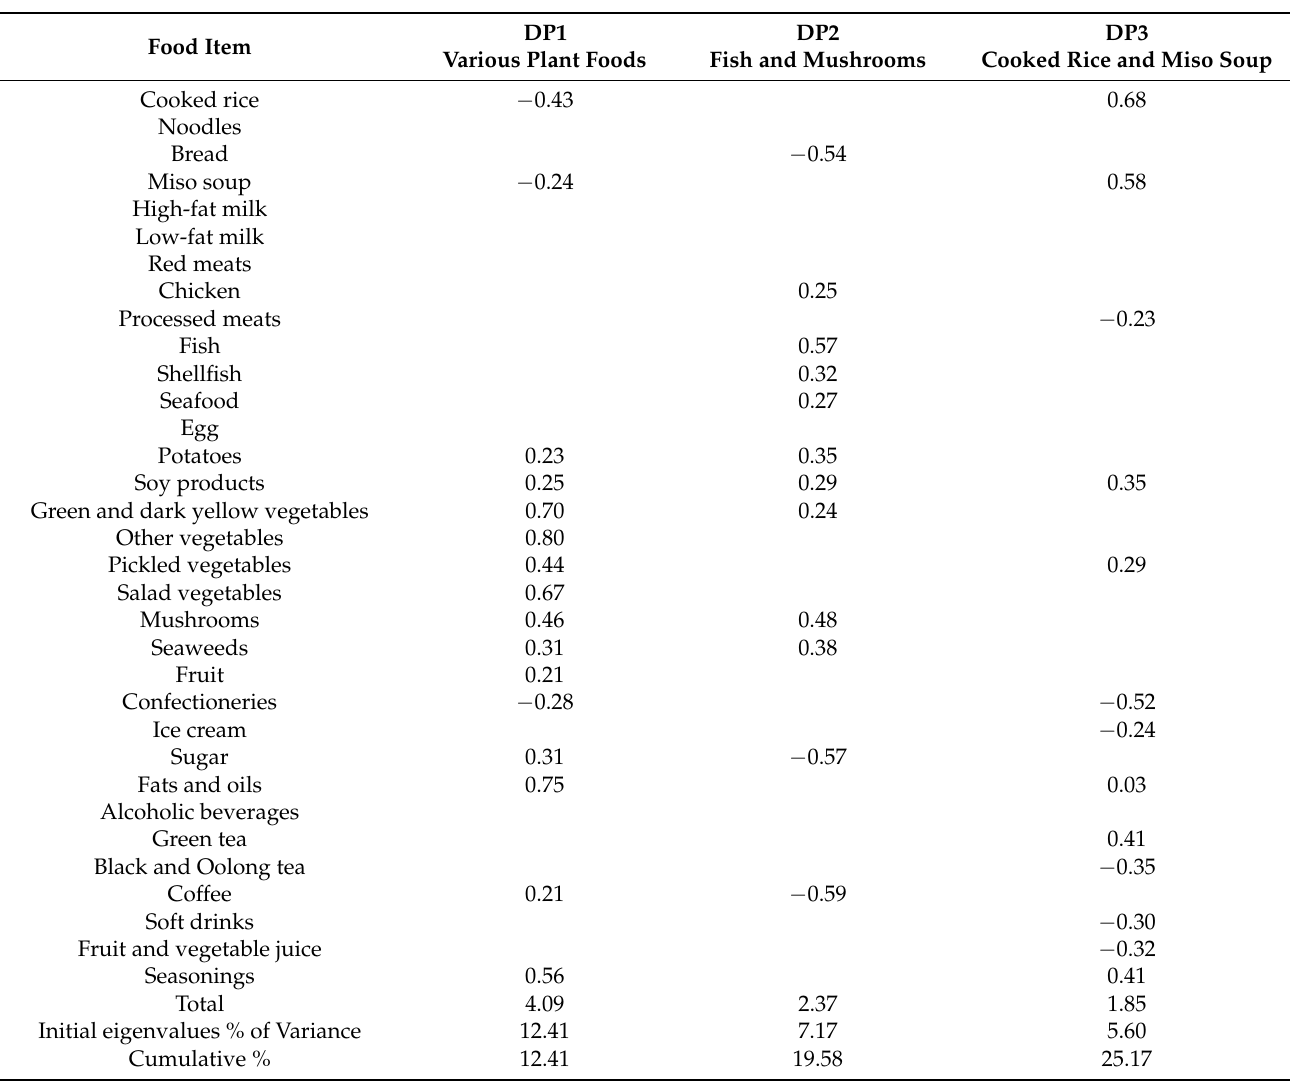
Table 2. Identification of dietary